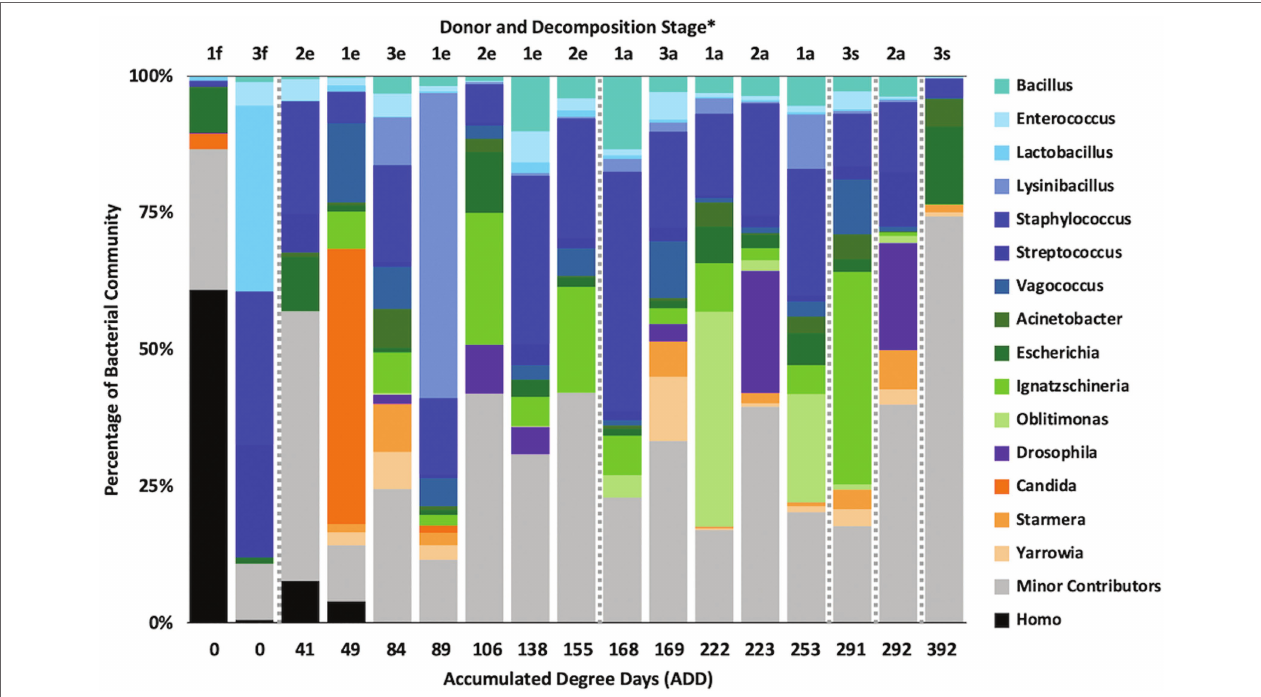
FIGURE 12 | Proportions of bacterial and eukaryotic genera determined from shotgun MetaT sequencing from oral samples of three human donors (Donors 1, 2, and 3) during decomposition. Decomposition was assessed as ADD on the x -axis and samples were also classified to an overall decomposition stage for each donor at each sampling event ( * f , fresh; e , early; a , advanced; and s , skeletonized). Minor contributors include data that accounted for <3% of the total diversity within a